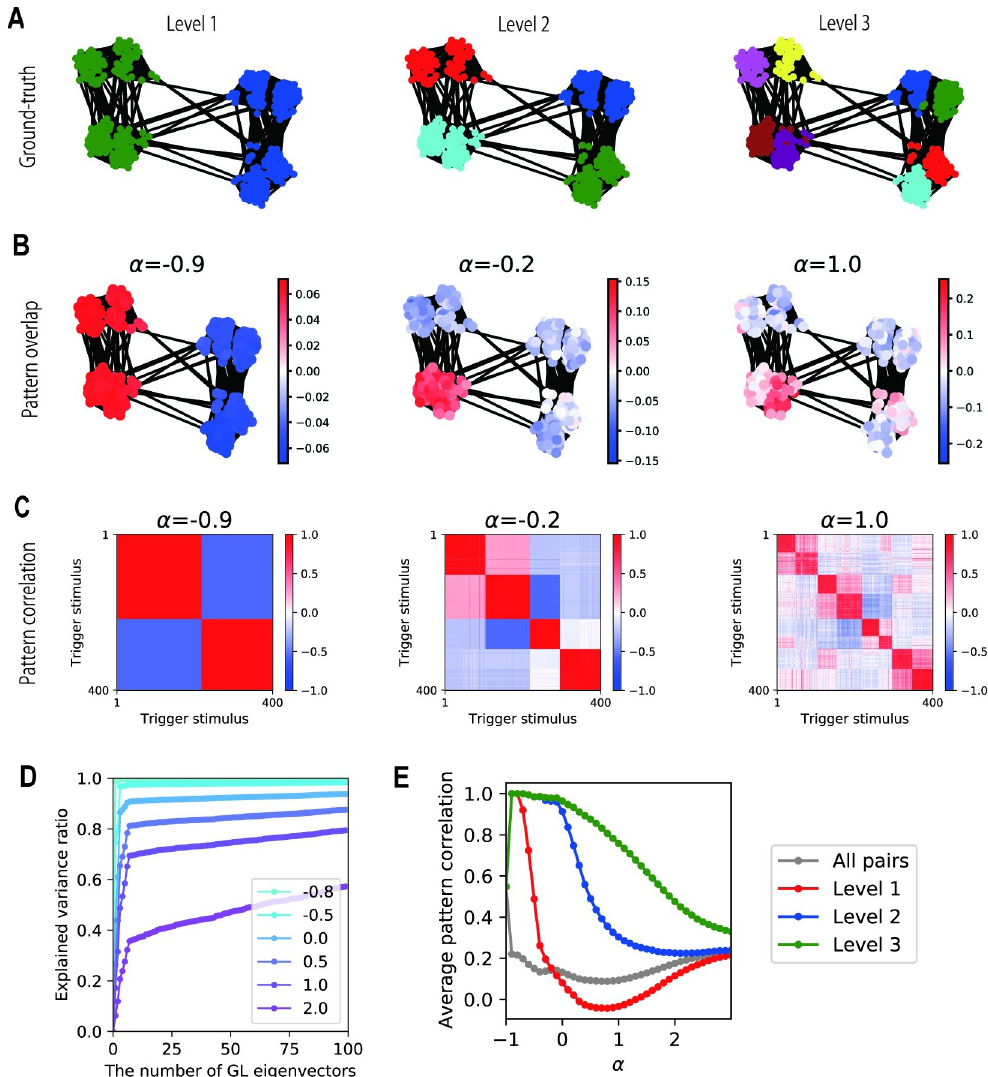
Fig 4. Representations of LAM for a random graph with a hierarchical community structure. (A) A structure of an example random graph (400 nodes) and three hierarchical levels of communities. (B) Pattern overlaps of attractors in LAM. (C) Pattern correlation matrices between attractors in LAM. (D) The explained variance ratio in linear regressions of pattern overlaps by various numbers of GL eigenvectors. The color indicates the value of α . (E) Average pattern correlations between attractor patterns of node pairs in each hierarchy. A level- h pair is in the same level- h community and not in the same level-( h +1) community if h <